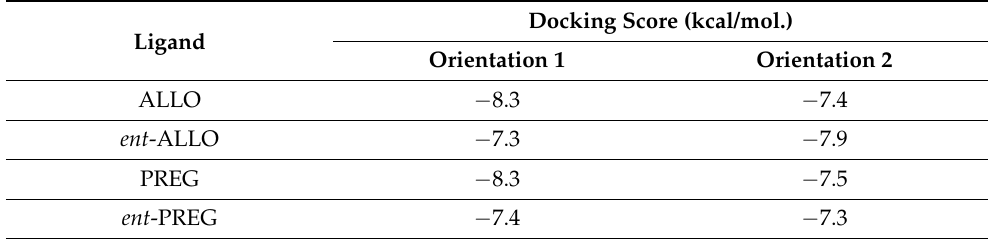
Table 1. Lowest energy Vina scores for docking of steroids in the β 3 / α 1 intersubunit neurosteroid binding pocket of the GABA A receptor using the Cryo-EM structure of an α 1 β 3 γ 2 receptor